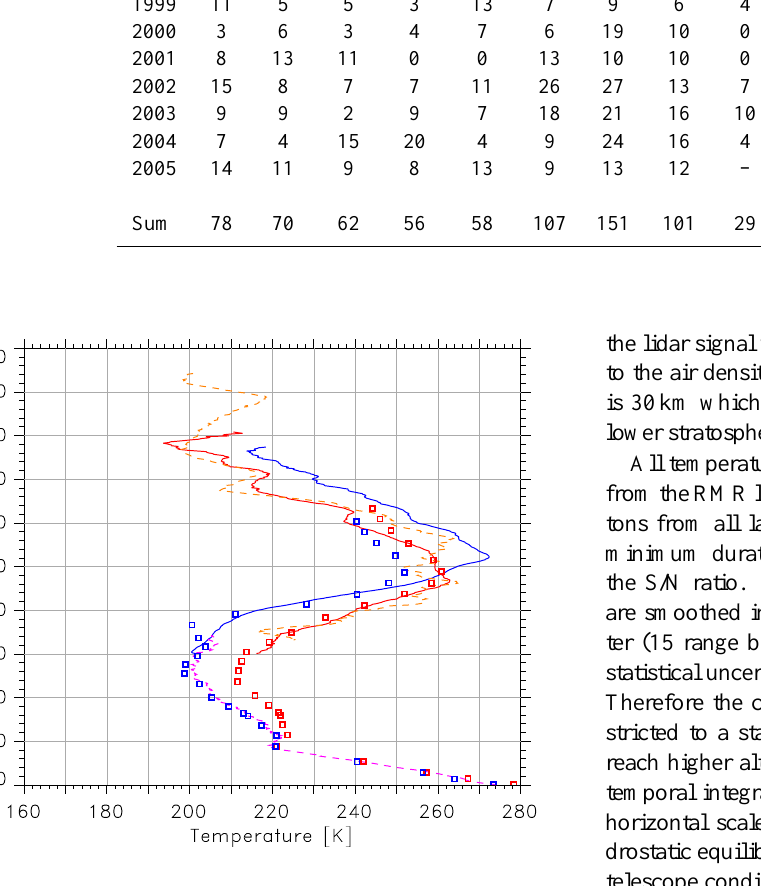
Fig. 2. RMR lidar temperatures calculated from Eq. (1) for 30 September 2002 (red) and 7 November 2002 (blue). Tem- perature profiles from simultaneous falling sphere (30 September 2002, orange) and radiosonde (7 November 2007, violet) measure- ments as well as from ECMWF operational analyses (squares) at (70 ◦ N, 15 ◦ E) are included to show that the lidar temperature mea- surements agree with other independent